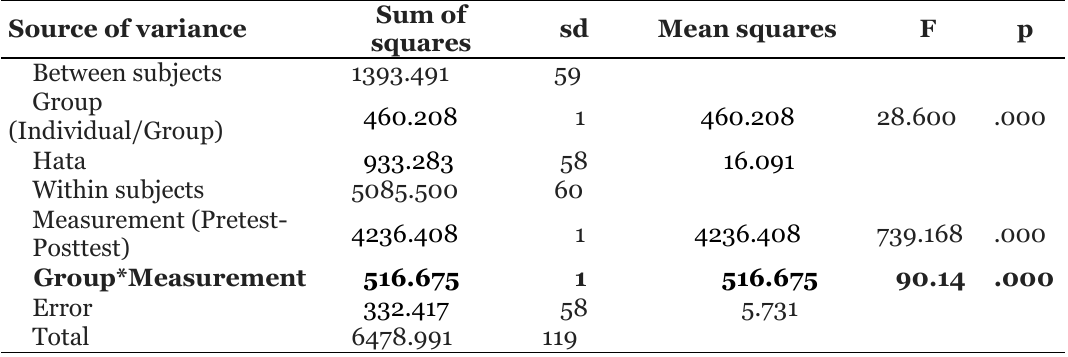
ANOVA Results of Learning Environments Relating to Pretest-Posttest